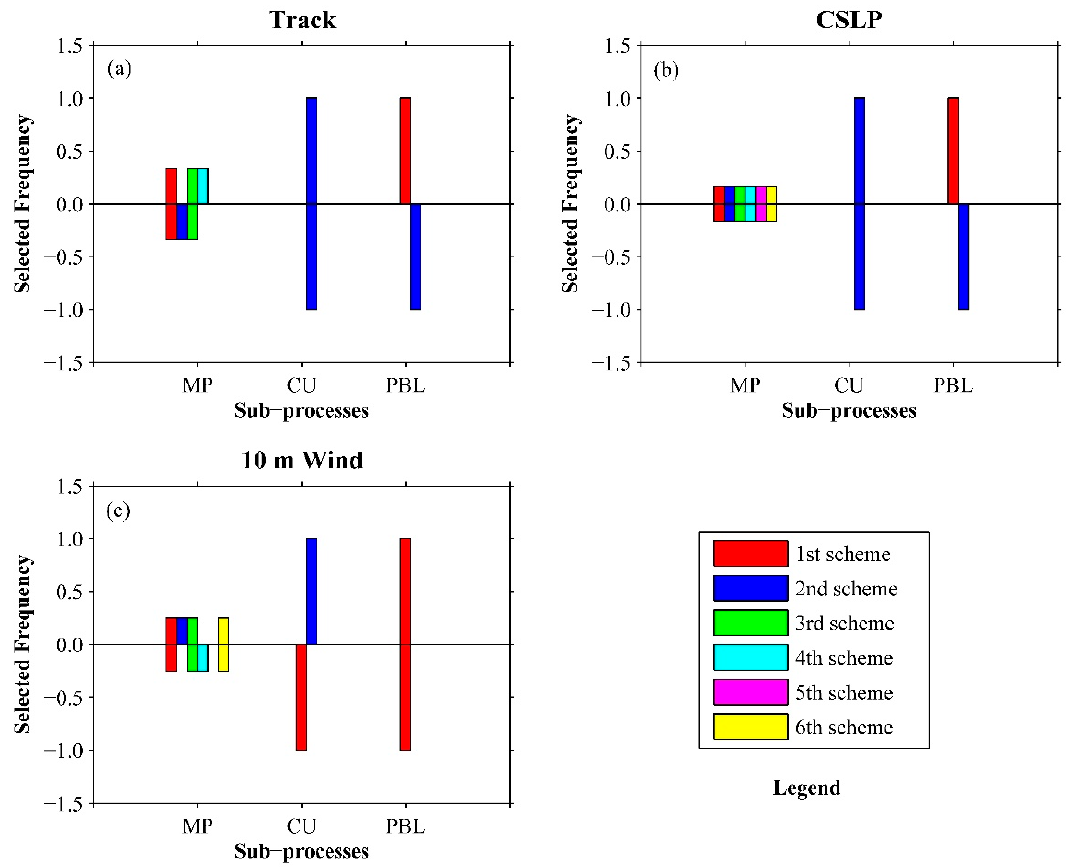
Figure 6. Selected frequency of the different schemes as the best or worst member for the fifth round of scheme combinations for ( a ) track, ( b ) CSLP, and ( c ) 10m wind. The positive bar value represents the frequency of the scheme as the best member, and the absolute values of the negative bar represent the frequency of the scheme as the worst member.